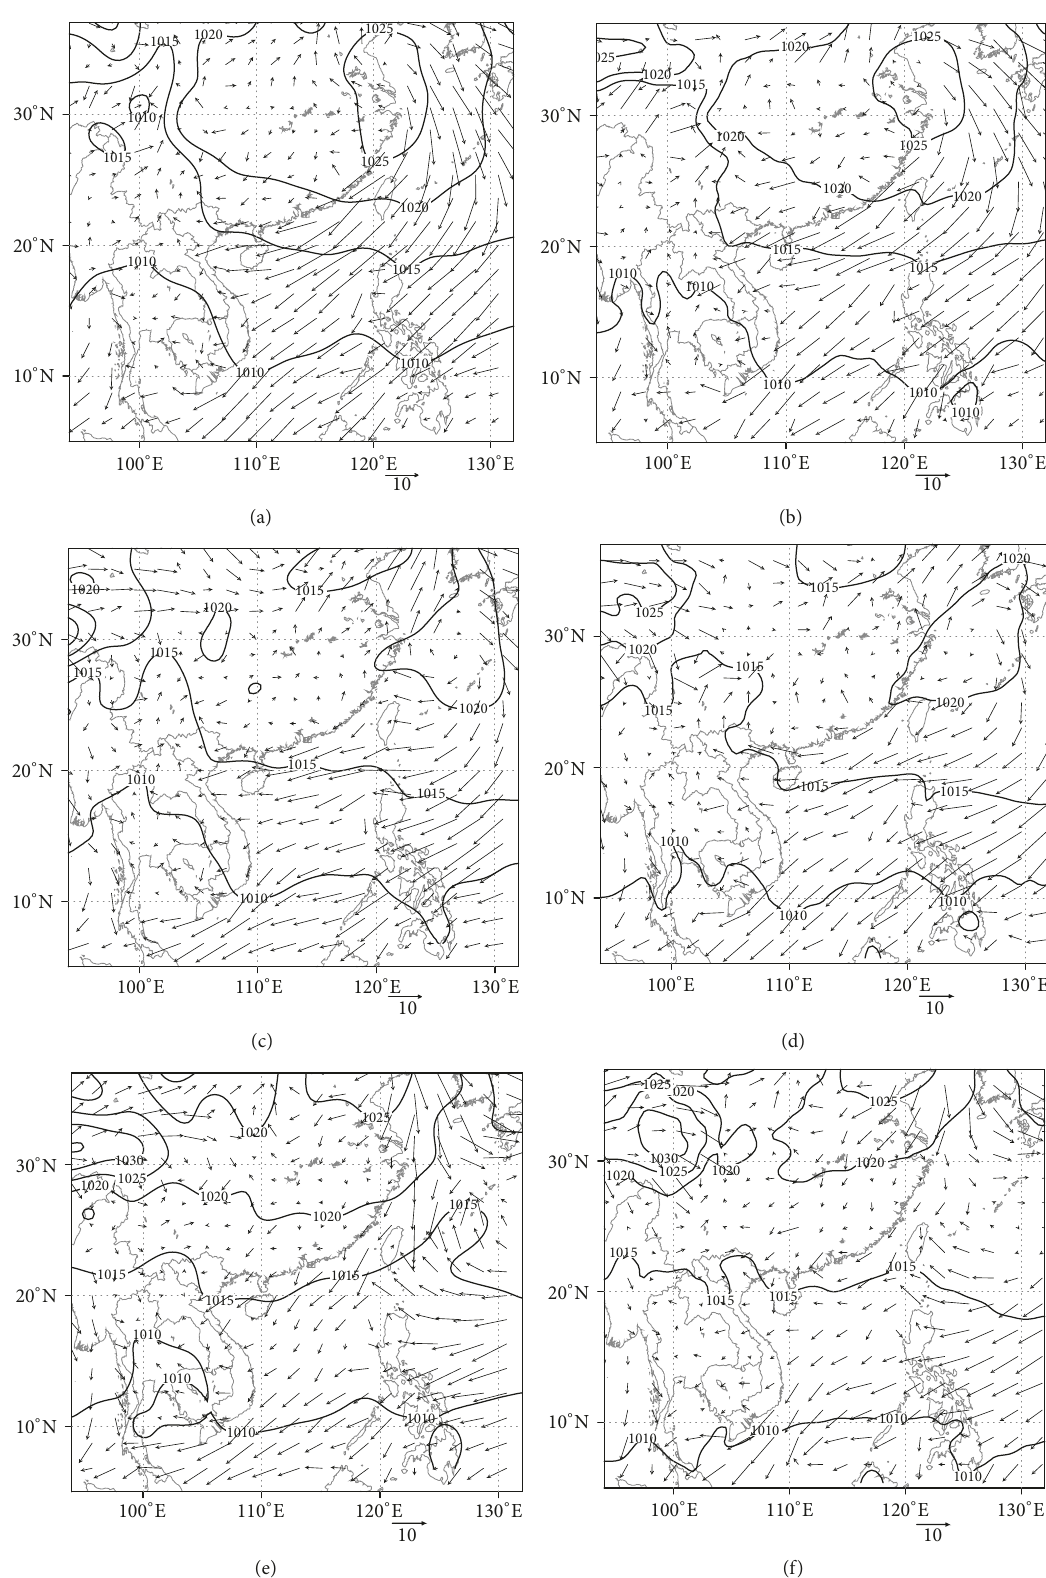
Figure 2: Sea level pressure (unit: hPa) and wind distribution (unit: m s −1 ) at 12:00 on 31 December 2009 (UTC) for (a) NCEP data and (b) PRE-URBAN test, 12:00 on 1 January 2010 (UTC) for (c) NCEP data and (d) PRE-URBAN test, 12:00 on 2 January 2010 (UTC) for (e) NCEP data and (f) PRE-URBAN